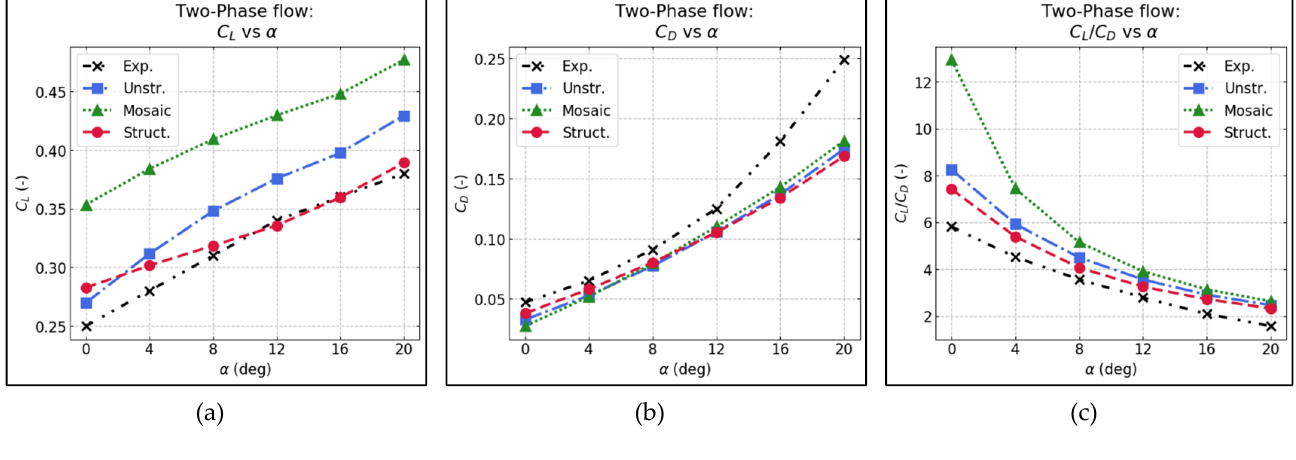
Figure 15. ( a ) Lift coefficient of wing from numerical simulations under 3 different meshes and comparison with experimental results (two-phase flow) ( b ) Drag coefficient of wing from numerical simulations under 3 different meshes and comparison with experimental results (two-phase flow) ( c ) Aerodynamic efficiency of wing from numerical simulations under 3 different meshes and comparison with experimental results (two-phase flow air–sand).